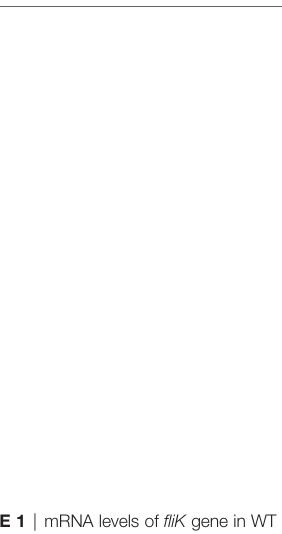
FIGURE 1 | mRNA levels of fl iK gene in WT and mutant strains of P. plecoglossicida . * P < 0.05, ** P